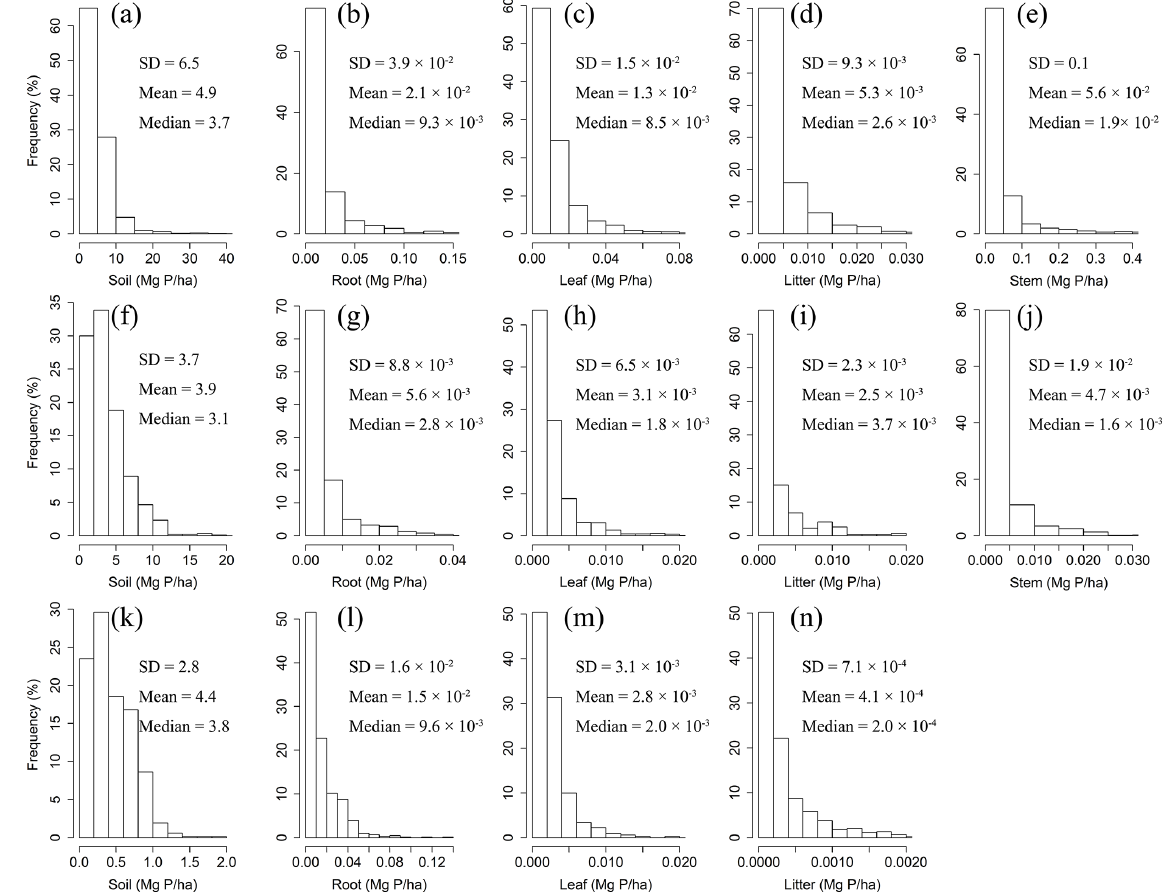
Figure 2. Frequency distributions of P densities in soil, roots, leaves, litter, and woody stems in forests (a–e) , shrublands (f–j) , and grasslands (k–n) in